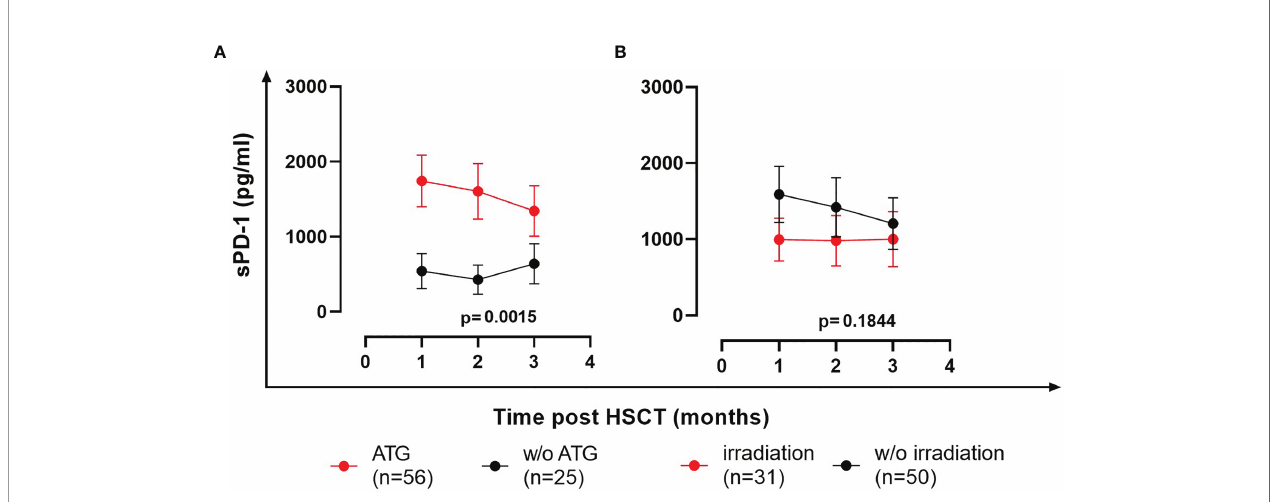
FIGURE 7 | Effects of ATG (A) and total body irradiation (B) on the course of sPD-1 levels post HSCT. Data are presented as mean ± SEM. sPD-1 levels of treated and untreated (w/o) patients are shown in red and black, respectively. One ATG-patient died within the fi rst month post HSCT and hence was not included in the